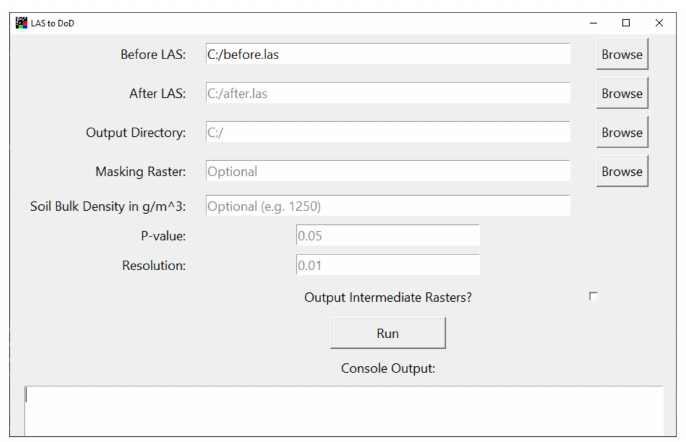
Figure 2. Las2DoD GUI